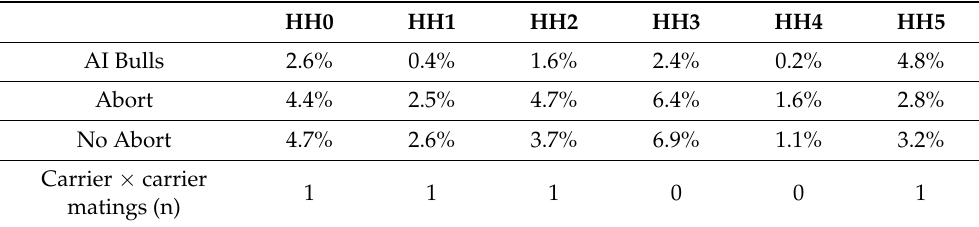
Table 8. Frequencies of Holstein haplotype (HH) carriers for genomically-tested AI bulls for breeding that resulted in abortion, and for cows that did and did not abort.